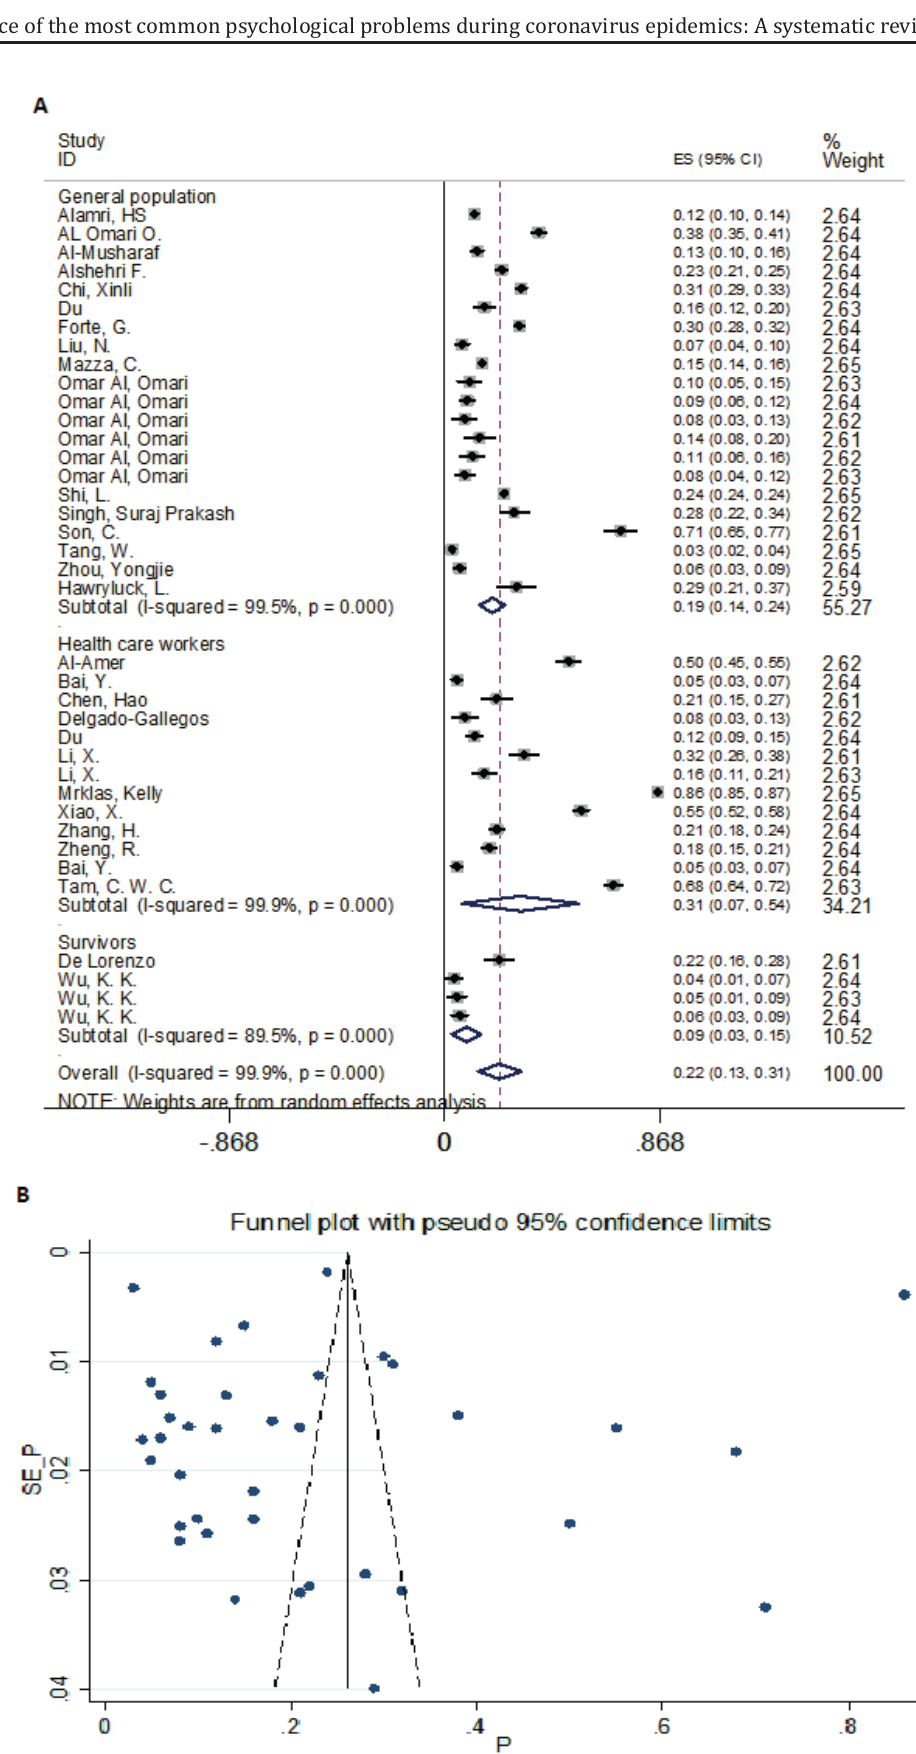
Fig 4. A: Forest plot; Pooled estimate prevalence of stress during coronavirus epidemics sub-grouped by the study population. B: Funnel plot; no publication bias observed in studies (Egger’s test p-value =